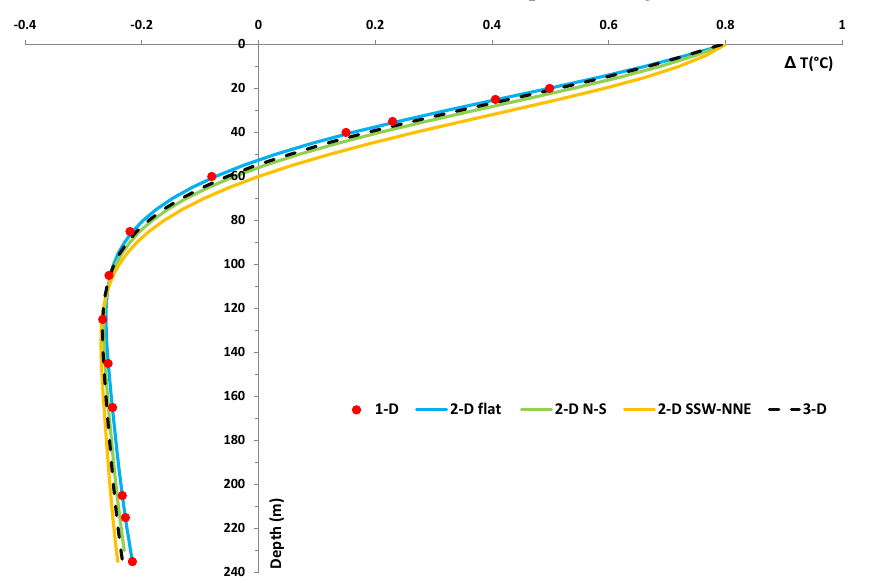
Figure B1. Comparison of predictions of the forward model for the same GST and different geometrical setups. Legend: 1-D: red dots; 2-D flat terrain: blue line; 2-D N–S: green line; 2-D SSW–NNE: orange line; 3-D: dashed black line (see the Appendix for the